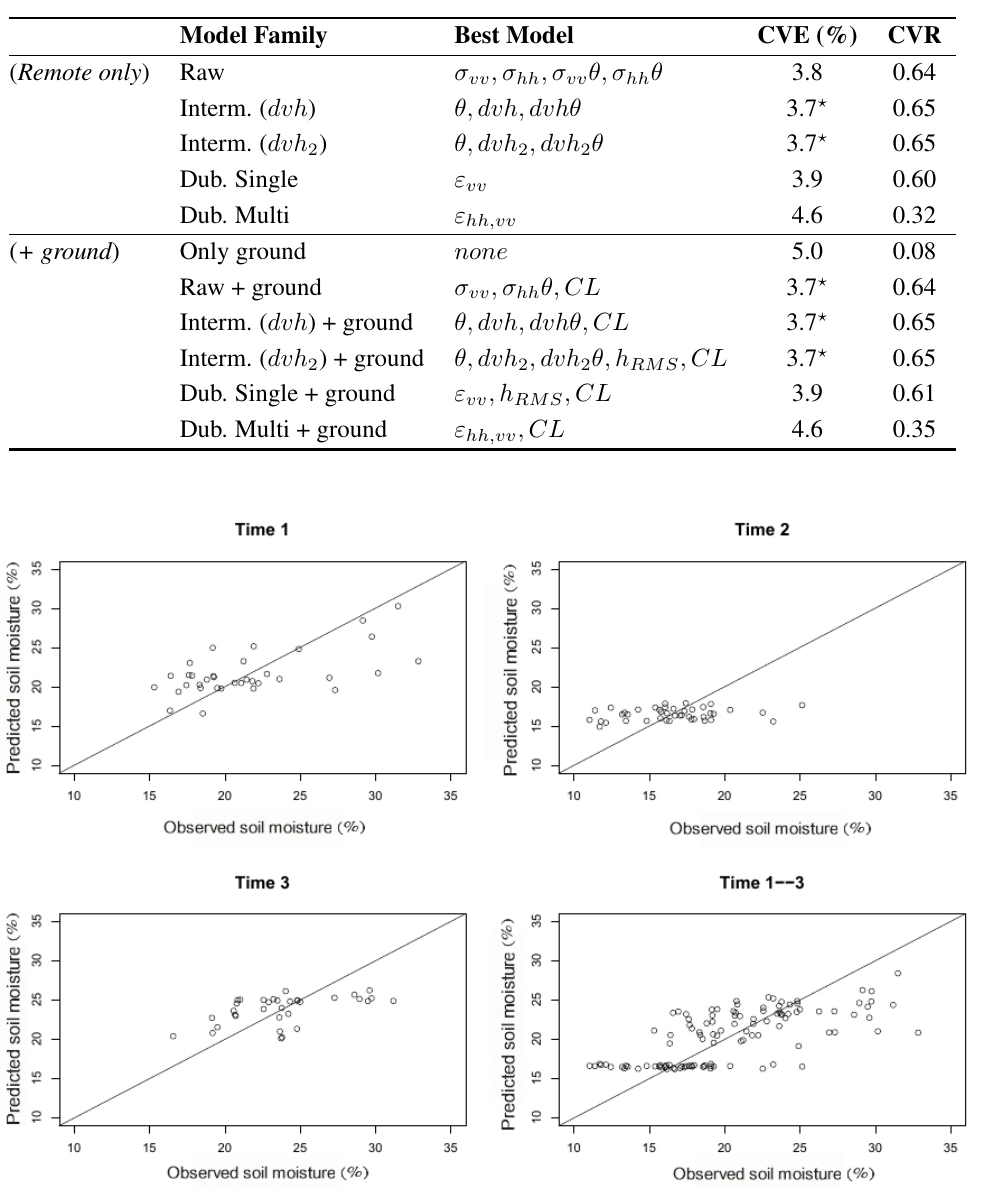
Figure 8. Cross-validation predictions of the best-performing model predicted versus observed of soil moisture (m)(%) for Times 1,2, 3, and all times pooled. The y = x line is also shown, whereby better fits have values that lie closer to this